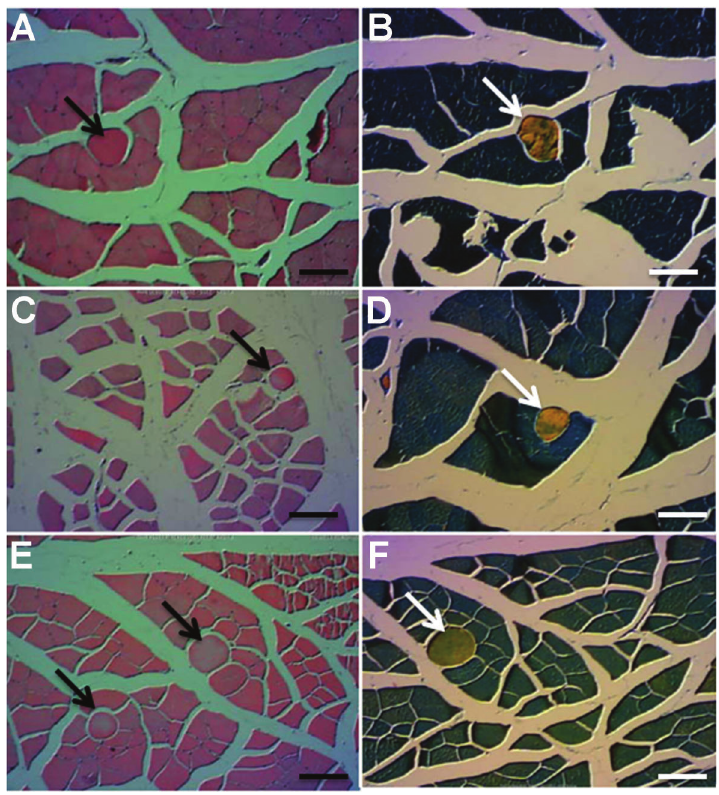
Figure 4. A , Control group, presence of hetero- topic ossi fi cation (arrow) stained with hematoxylin and eosin (HE). B , Control group, con fi rmation of heterotopic bone formation (arrow) with Mallory ’ s trichrome. C , Functional electrical stimulation (FES) group, presence of heterotopic ossi fi cation (arrow) stained with HE. D , FES group, con fi rma- tion of heterotopic bone formation (arrow) with Mallory ’ s trichrome. E , Transcutaneous electrical nerve stimulation (TENS) group, presence of heterotopic ossi fi cation (arrow) stained with HE. F , TENS group, con fi rmation of heterotopic bone formation (arrow) with Mallory ’ s trichrome. Scale bars = 100 m